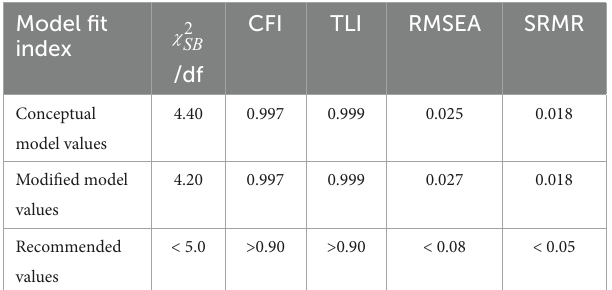
TABLE 7 Goodness-of-fit indices of the tested models and recommended values ( N =